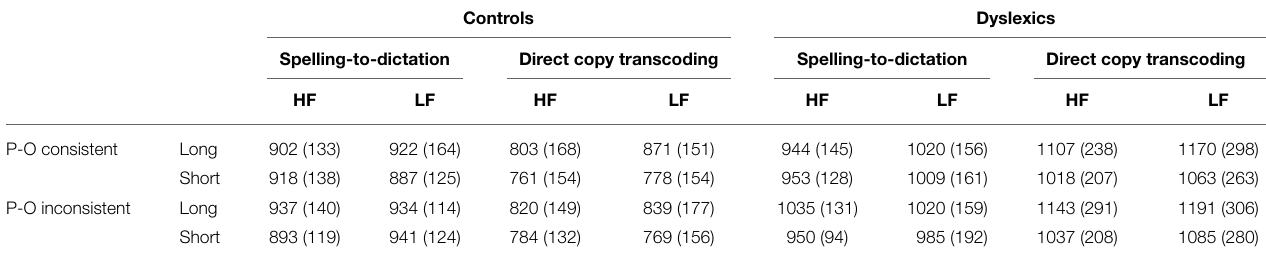
TABLE 2 | Mean written latencies (in milliseconds) and standard deviations (in parentheses) of control and dyslexic participants.